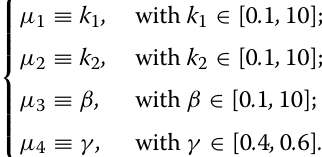
• The length of the first section is equal to γ